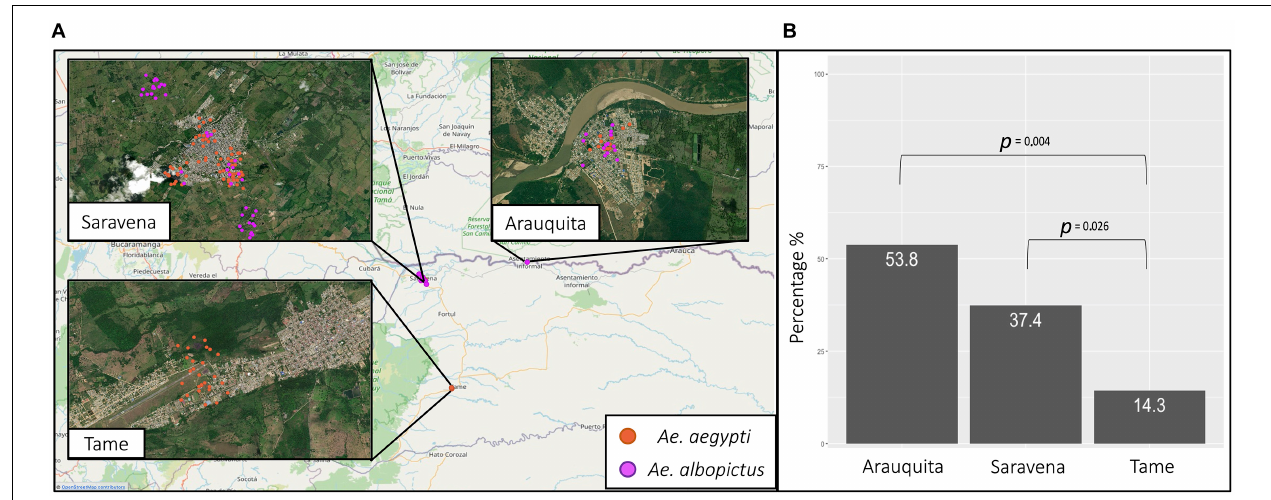
FIGURE 4 | (A) The geographic location of A. aegypti (orange) and A. albopictus (purple) collected from the municipalities of Saravena, Arauquita, and Tame. (B) The percentage of individuals infected by the municipalities of Arauquita, Saravena, and